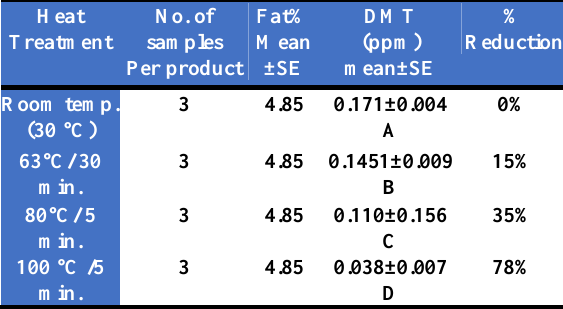
Table, 2: The effect of different industrial heat treatments on the degradation of the Deltamethrin residues (ppm) in cow's milk. Heat No. Treatment